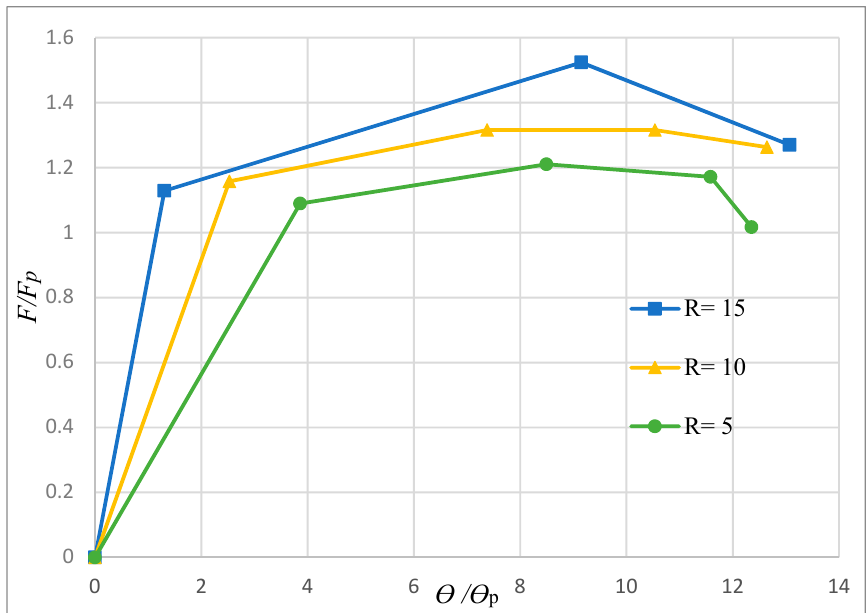
Figure 2. Normalized resistance against normalized